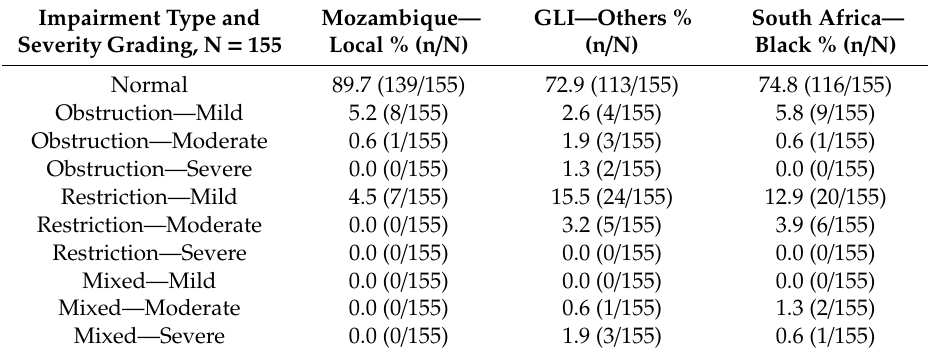
Table 3. Comparison of outcome categories using Mozambican prediction equations versus South African and GLI